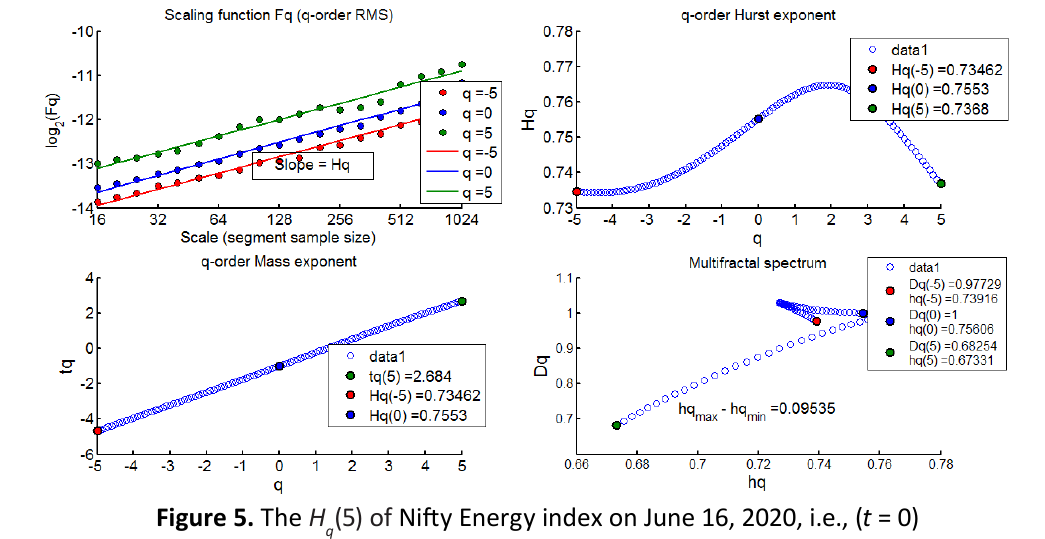
(5) of Nifty Energy index on June 16, 2020, i.e., ( t = 0) Figure 5. The H q